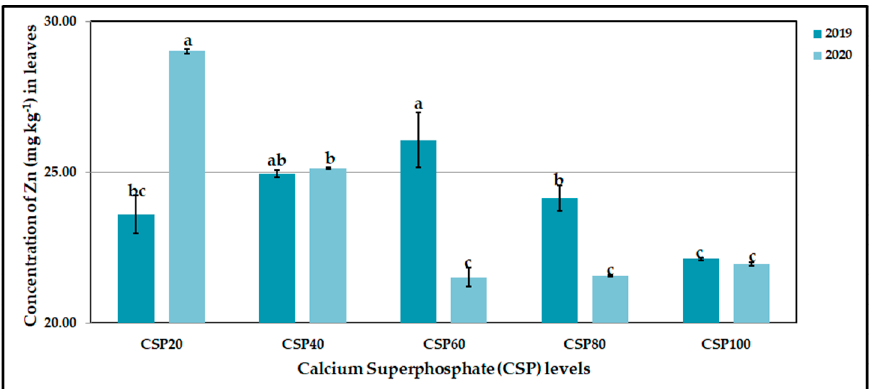
Figure 3. Influence of calcium superphosphate (CSP) levels on leaf zinc (Zn, mg kg − 1 ) contents of CaCO 3 -stressed sweet potato plants in 2019 and 2020 seasons. Bars with a different letter indicate significant difference between treatments at p ≤ 0.05. CSP 20 , CSP 40 , CSP 60 , CSP 80 , and CSP 100 represent CSP added as a soil application at 69, 138, 207, 276, and 345 kg ha − 1 ,